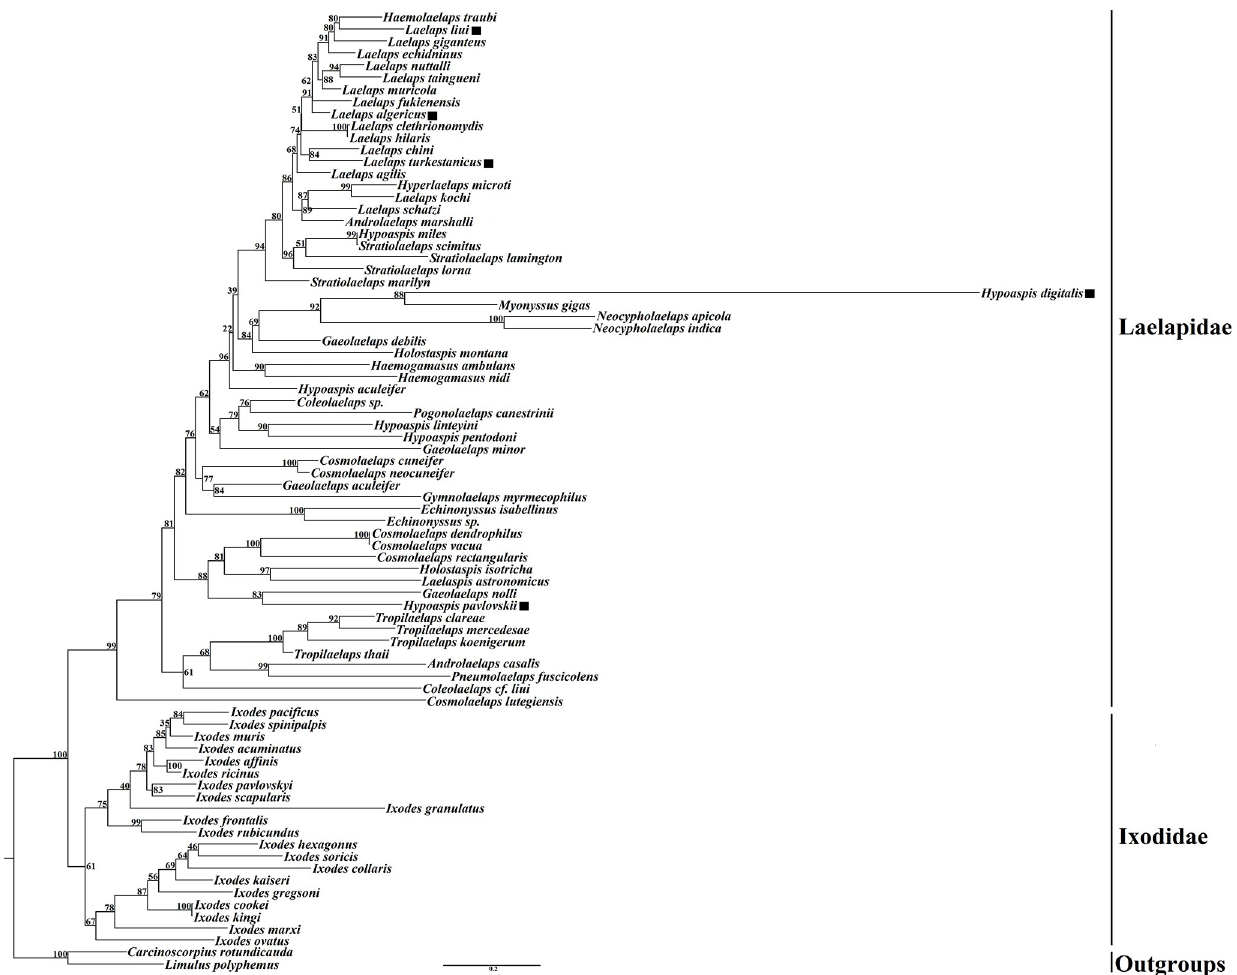
Fig 3. Maximum-likelihood tree constructed based on the cox1 gene sequence. The number on each node indicates the bootstrap probability (BP) and & indicates the species in this study.